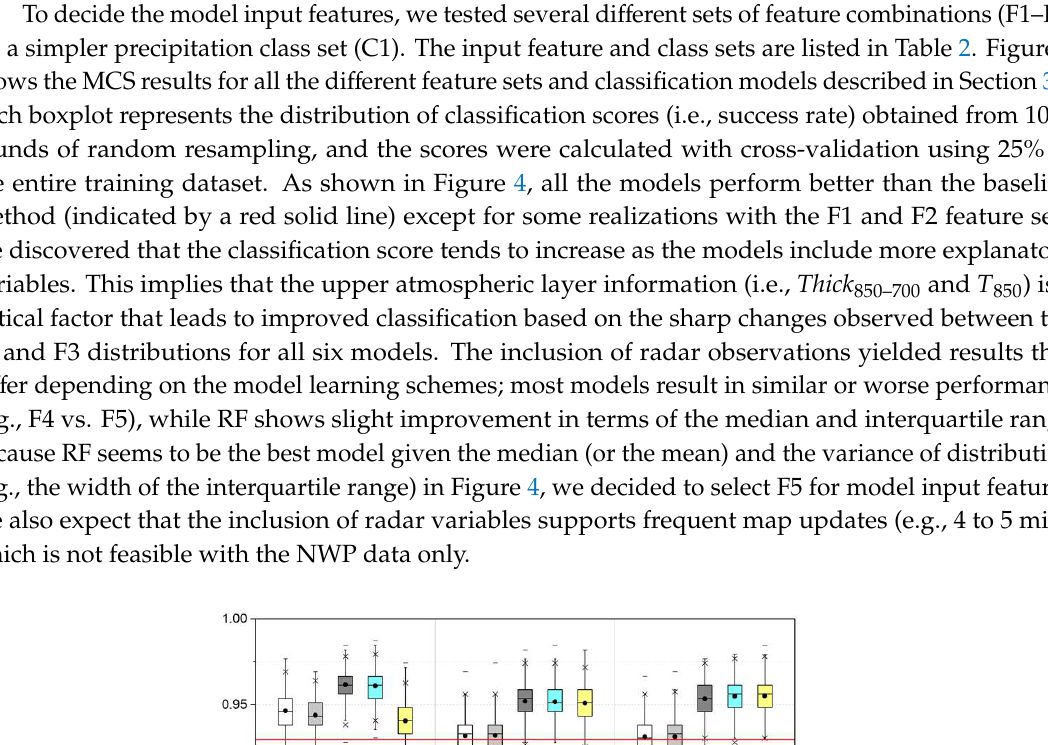
Figure 5. The comparison of MCS results for basic precipitation classes (C1) and further refinement of snow classes (C2). The feature set F5 was used for this analysis.